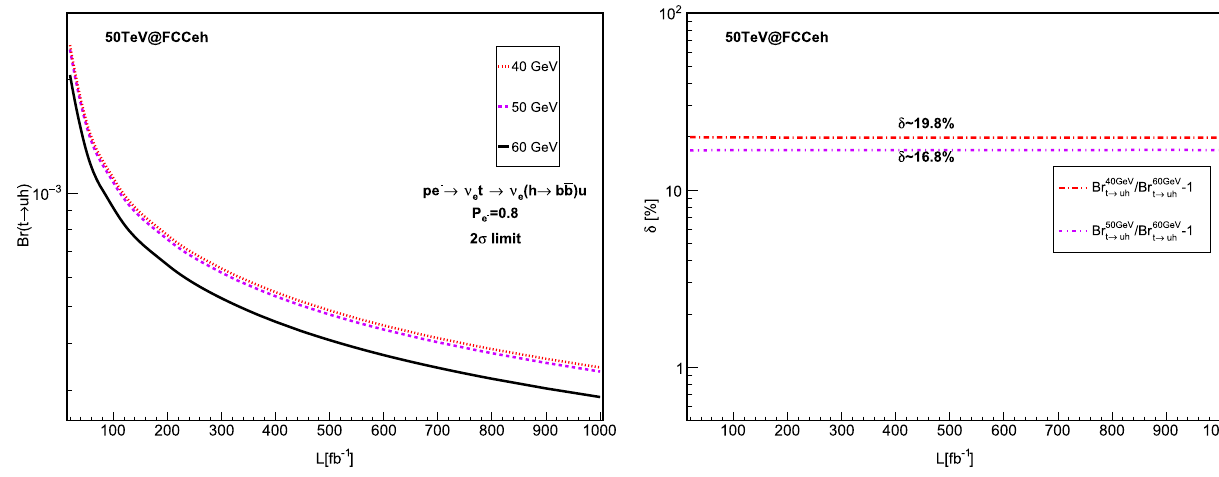
Fig. 8 The left panel is the 2 σ κ tuh limit as a function of the luminosities. The solid black, dashed violet and dotted red curves are for the 60, 50 and 40 GeV FCC-eh. The right panel is the ratio defined as δ E = Br